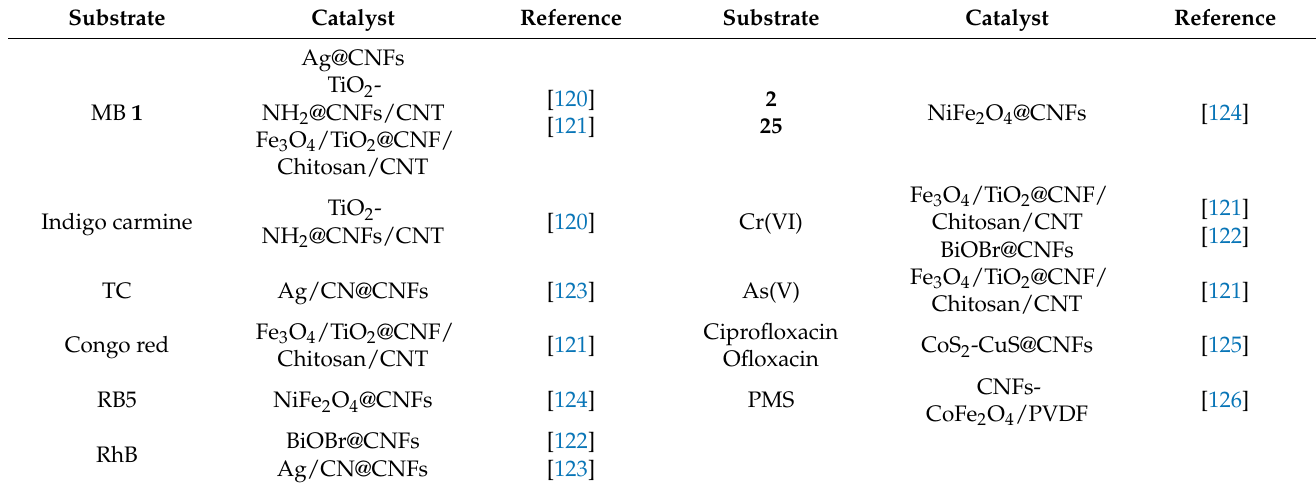
Table 12. Resume of the photocatalytic applications of inorganic-containing CNFs.